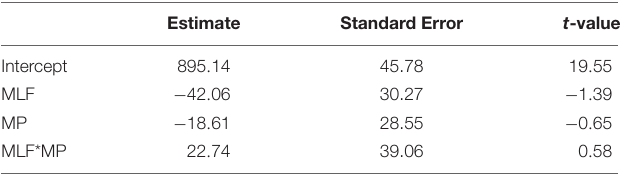
TABLE 7 | Fixed effect estimates derived from the linear mixed effects analysis on reaction time